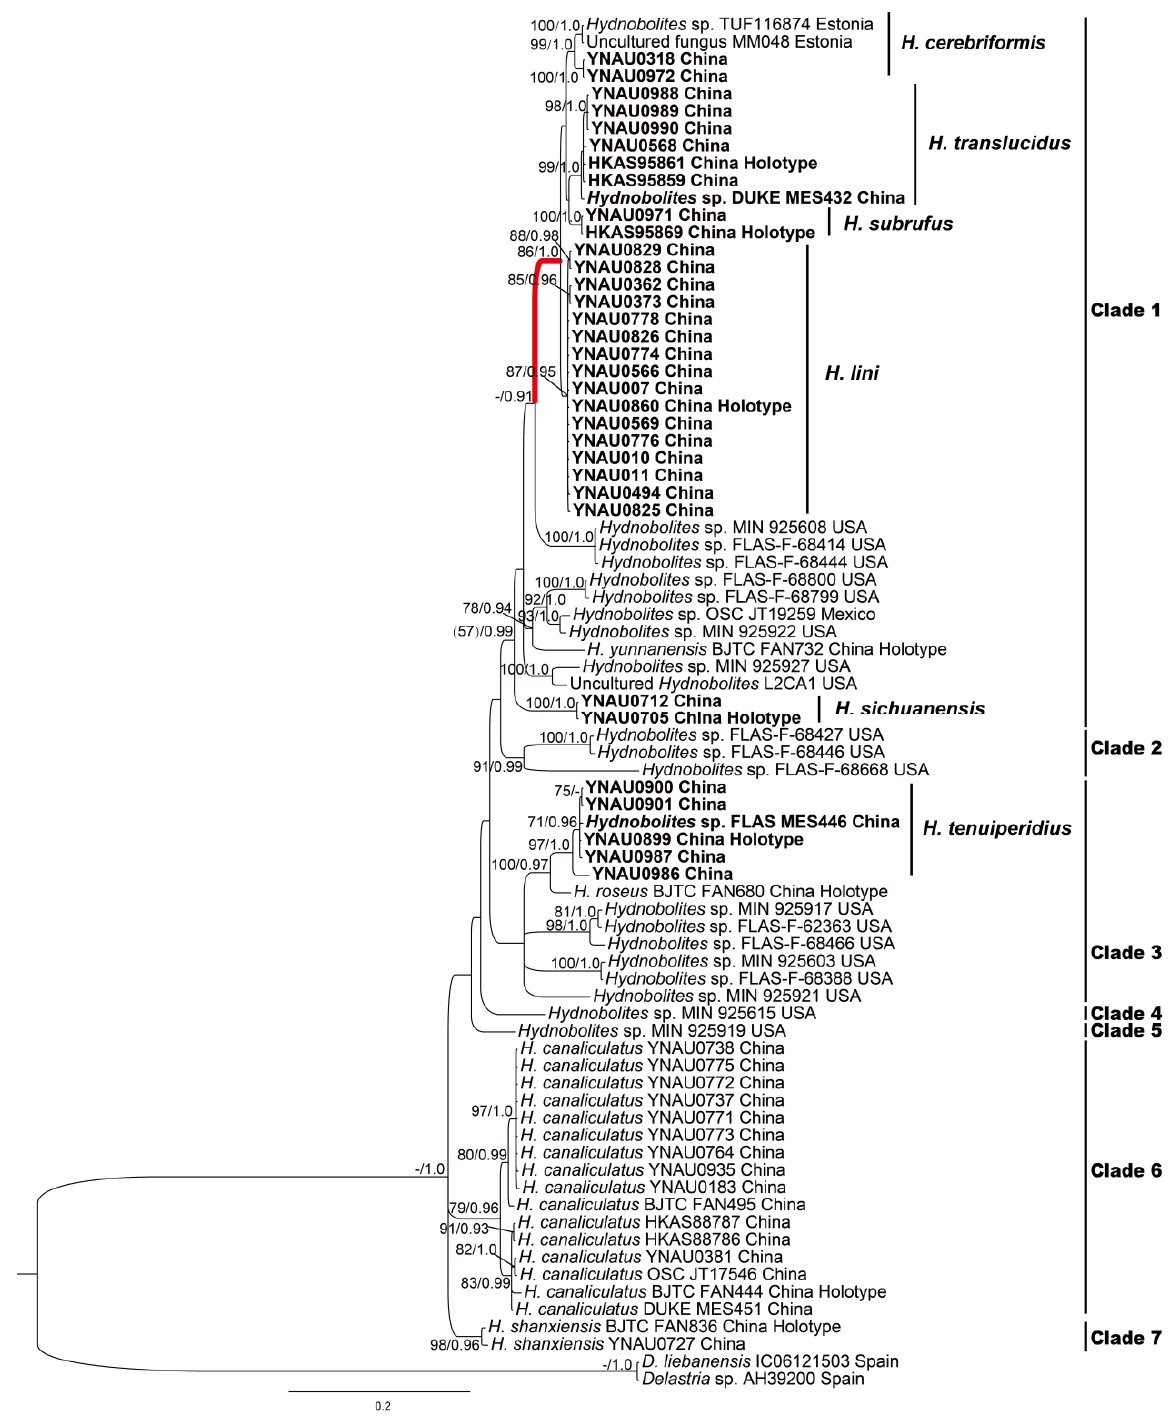
Figure 2. The consensus phylogram of the Genus Hydnobolites obtained in MrBayes of ITS-nrLSU. Nodes were annotated if supported by > 70% ML BP or > 0.90 Bayesian PP, but non-significant support values are exceptionally represented inside parentheses. New species are in bold font. Complex is reported as red thick branch.